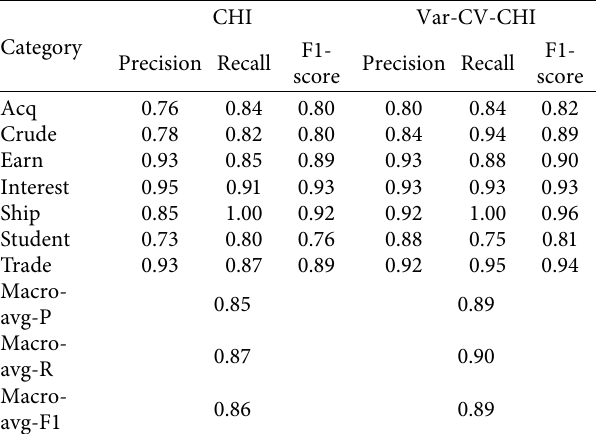
Table 9: Comparison of classification results between CHI and Var-CV-CHI on the unbalanced English corpus (Na¨ıve Bayes).